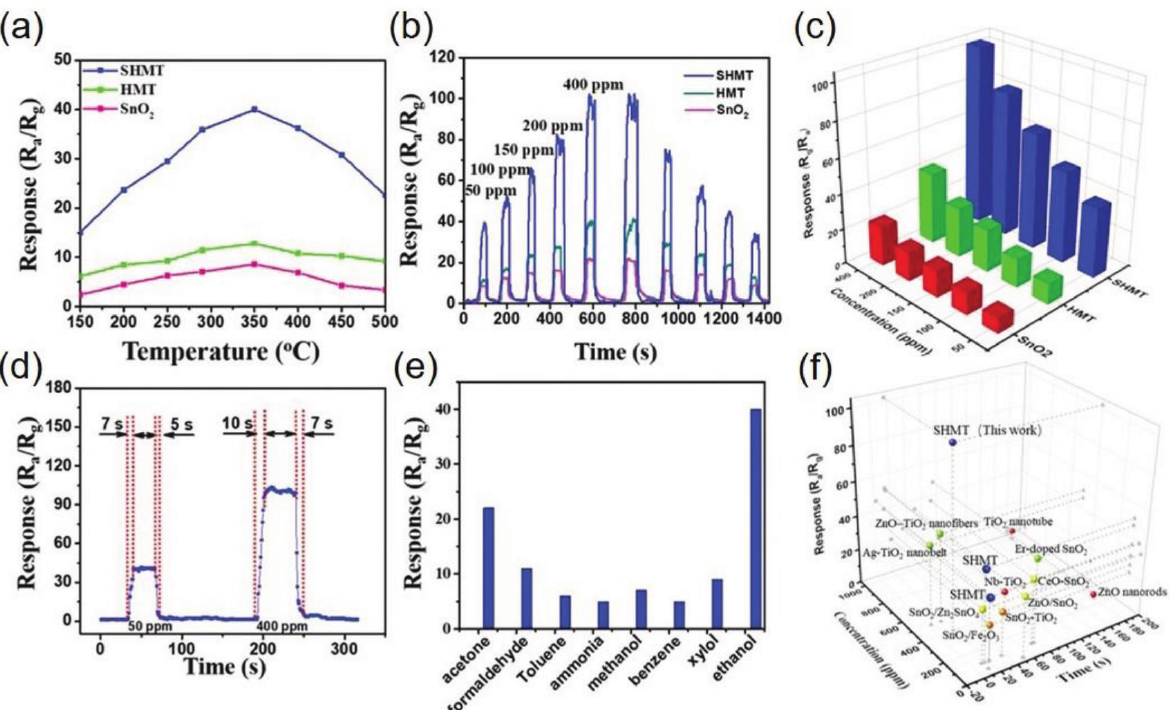
NCs, and SHMT‐based sensors toward 50 ppm ethanol at different operating temperatures Figure 8: (a) Responses of HMT, SnO 2 (150-500°C). (b) Response curves of gas sensors based on SnO NCs, HMT, and SHMT materials toward different concentration of ethanol 2 (50-400 ppm) at 350°C, (c) responses of the sensors based on SnO NCs, HMT, and SHMT sensors to ethanol vapor under different 2 concentrations (50-400 ppm). (d) Dynamic response‐recovery curve of the SHMT to 50 and 400 ppm ethanol. (e) Responses of SHMT sensor to various gases at 50 ppm to test the selectivity. (f) Comparison of the response and response/recovery time based on SMO sensors Reprinted with permission from Ref. [131]. Copyright 2019, John Wiley &